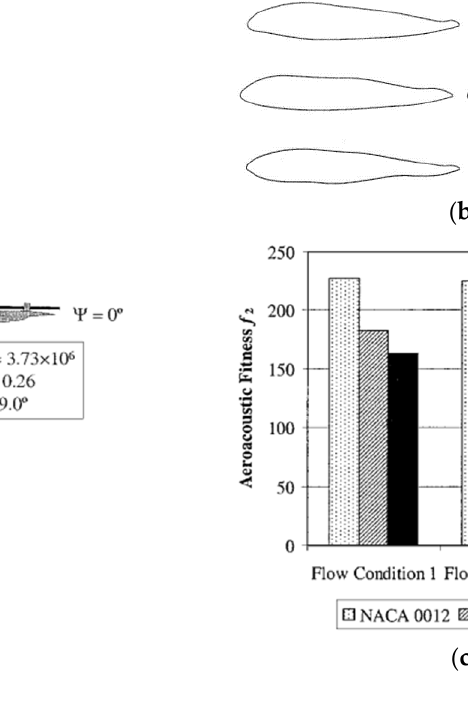
Figure 7. ( a ). Airfoil Design Conditions; ( b ). Resulting optimal airfoil shapes; ( c ). Plots showing Aeroacoustic fitness benefits [34]. Reprinted with permission from Lyrintzis, A.S. (2010).